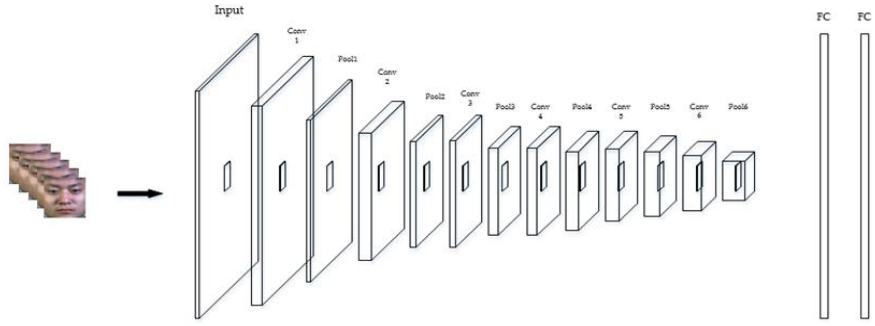
Figure 5. Basic network.